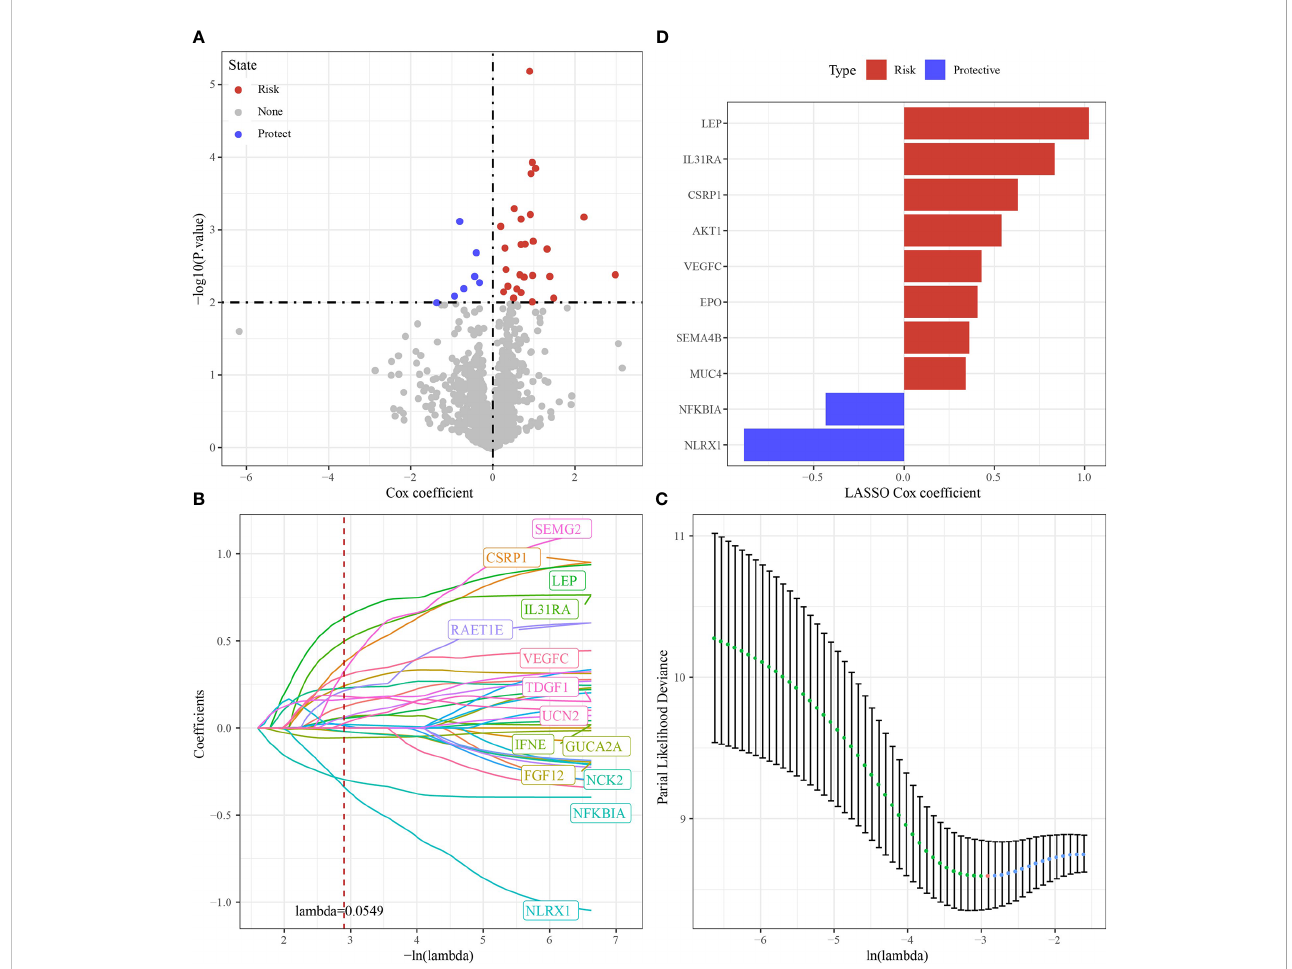
FIGURE 6 Identi fi cation of hub immune genes. (A) A total of promising immune genes candidates were identi fi ed through Lasso Cox regression. (B) The trajectory of each independent variable as lambda changes. (C) Con fi dence intervals under lambda. (D) Distribution of LASSO coef fi cients of the immune prognostic gene signature.